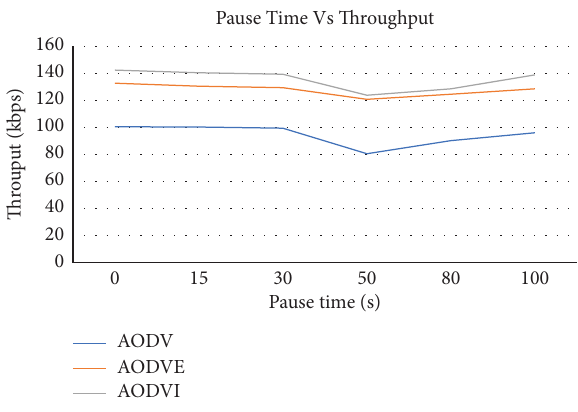
Figure 5: Pause time vs